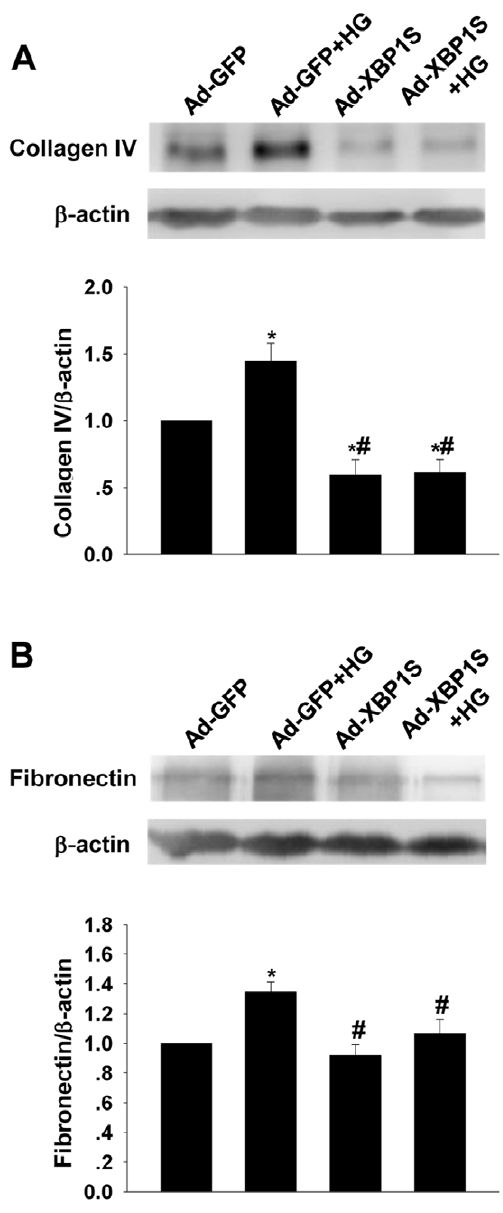
Figure 5. Western blot analysis on ECM expressions in the cultured MCs with or without Ad-XBP1S transfection for 48 h. A: Collagen IV; B: Fibronectin (mean 6 SEM, n=5). * p , 0.05 compared to NG; # p , 0.05 compared with